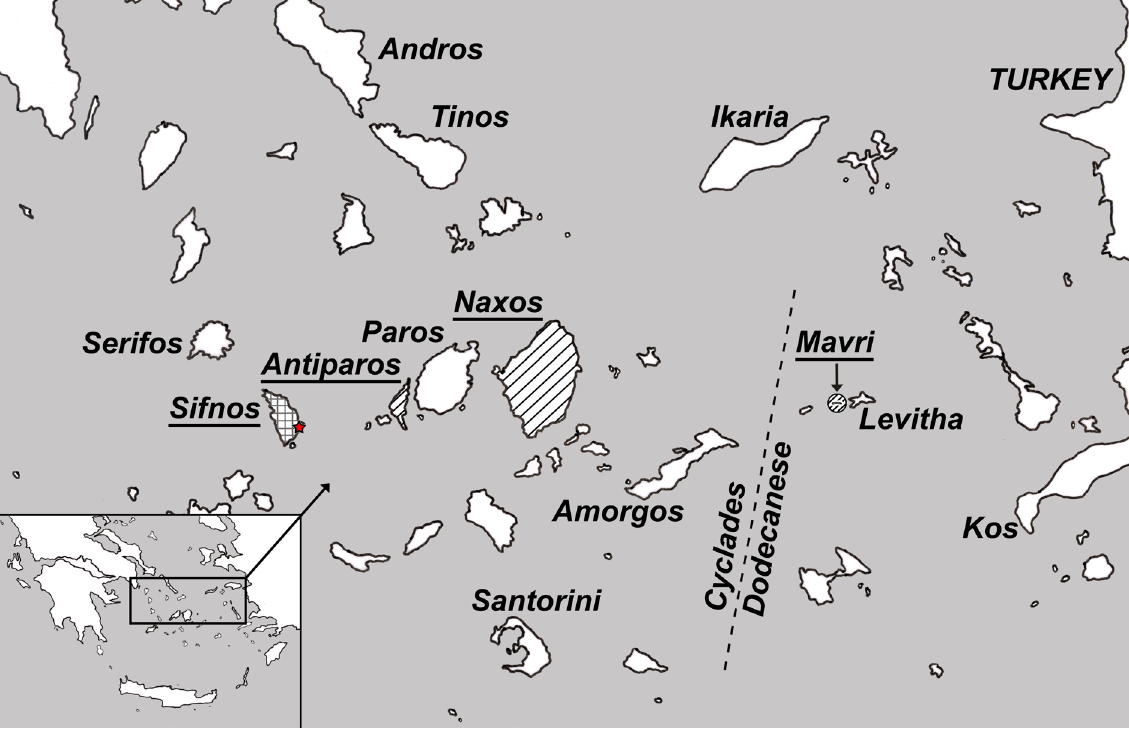
Fig. 5. Distribution map of Enghophyllum gen. nov. The checked area (Sifnos Island) represents the possible distribution of E. sifnium gen. et sp. nov.; the red star shows Faros, its type locality. The obliquely lined areas (Antiparos and Naxos Islands, Mavri Islet) show the distribution of E. naxium